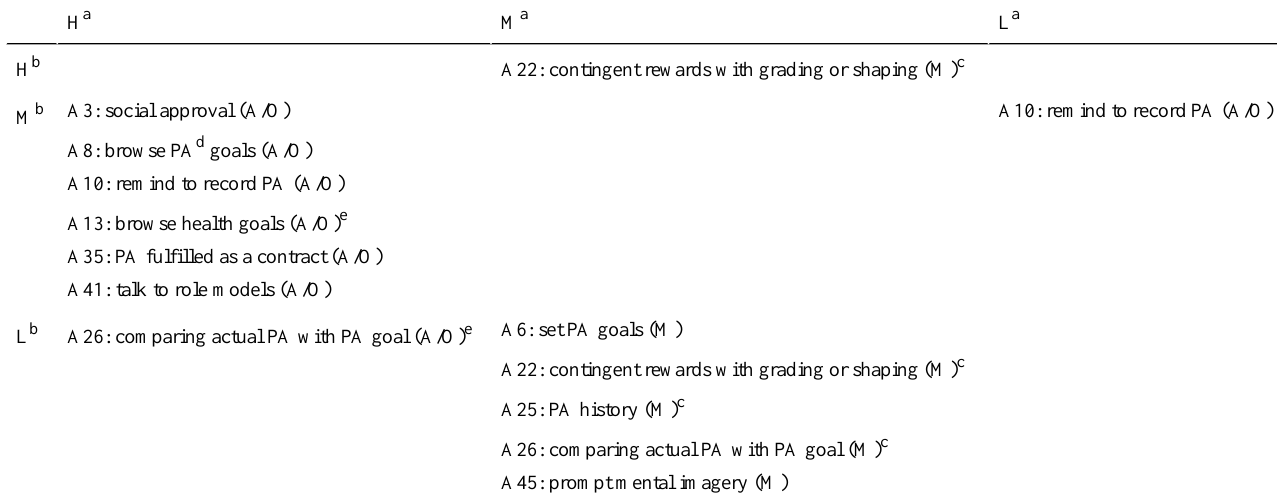
Table 18. The quality categories of design features with significant mobile phone self-efficacy (MPSE)